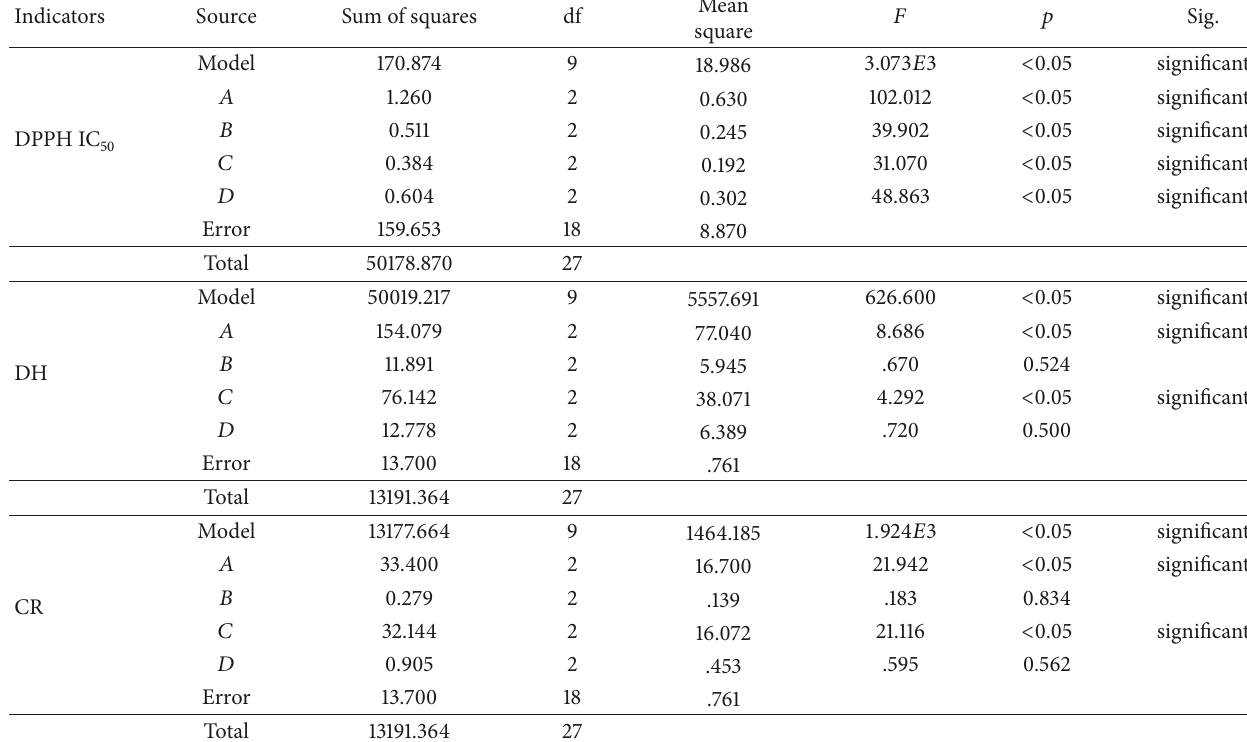
Table 2: Analysis of variance (ANOVA) on indicator parameters obtained from the L 9 (3 4 ) orthogonal experiment ( 𝑛 = 3 , Mean ± SD). 𝐴 , ultrasound powers; 𝐵 , ultrasound on/off time; 𝐶 , ultrasound temperature; 𝐷 , ultrasound time.